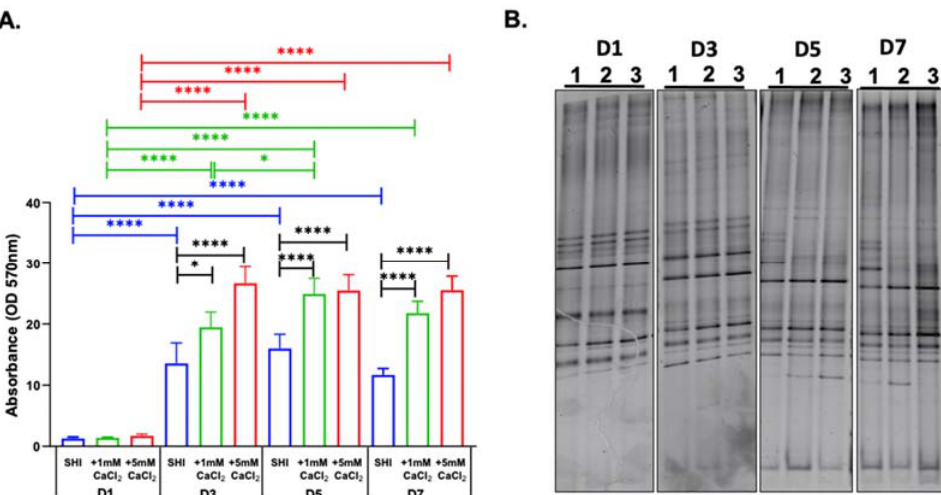
Figure 1. Effect of calcium ion supplementation on human-saliva-derived oral biofilms. The biofilms were grown in SHI medium (SHI), SHI medium + 1 mM CaCl 2 (+1 mM CaCl 2 ), and SHI medium + 5 mM CaCl 2 (+5 mM CaCl 2 ), and evaluated at day 1 (D1), day 3 (D3), day 5 (D5), and day 7 (D7). ( A ) Biofilm biomass: The biomass was assessed by measuring crystal violet at the optical density of 570 nm. Black bars indicate comparisons between conditions at the same time point, whereas comparisons of the same medium condition between time points are indicated in blue (SHI), green (+1 mM CaCl 2 ), and red (+5 mM CaCl 2 ). * Represents p ≤ 0.05 and **** represents p ≤ 0.0001. ( B ) Microbial composition: Denaturing gradient gel electrophoresis (DGGE) profiles of iDNA (intracellular DNA) of oral microbial biofilms grown in 1. SHI medium, 2. SHI medium + 1 mM CaCl 2 , and 3. SHI medium + 5 mM CaCl 2 .